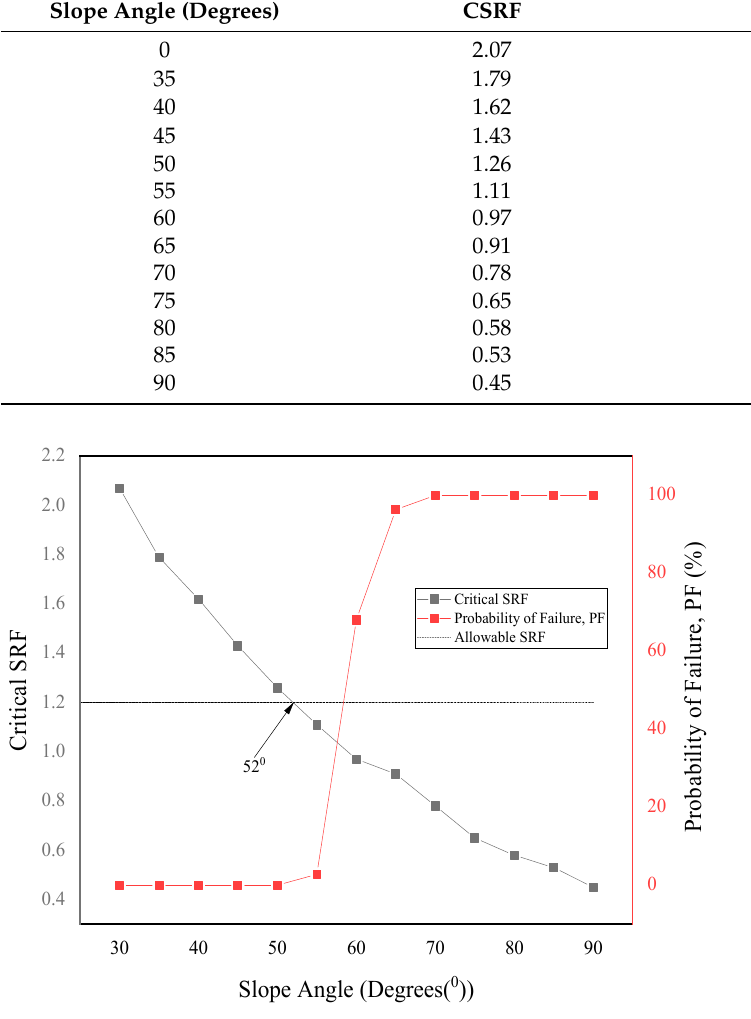
Figure 9. Graph of slope angle vs. strength reduction factor (FSRF) and probability of failure (PF).